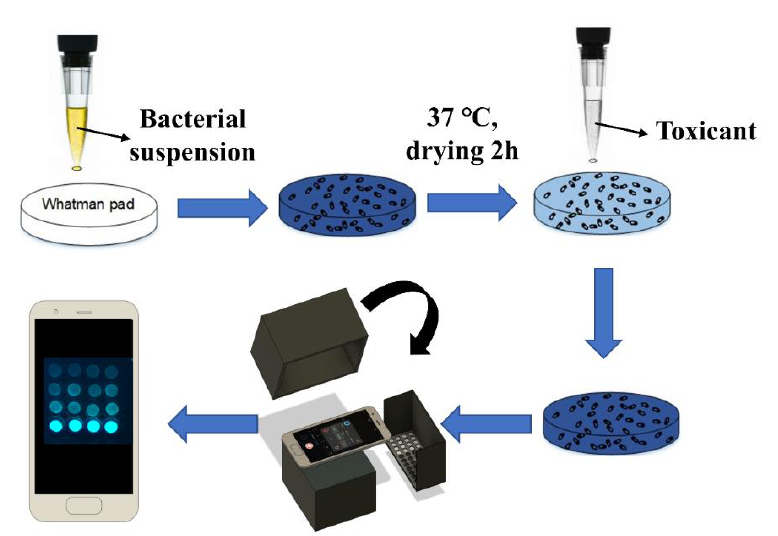
Figure 1. Bioluminescence signal measurement procedure of smartphone-based whole-cell biosensor.